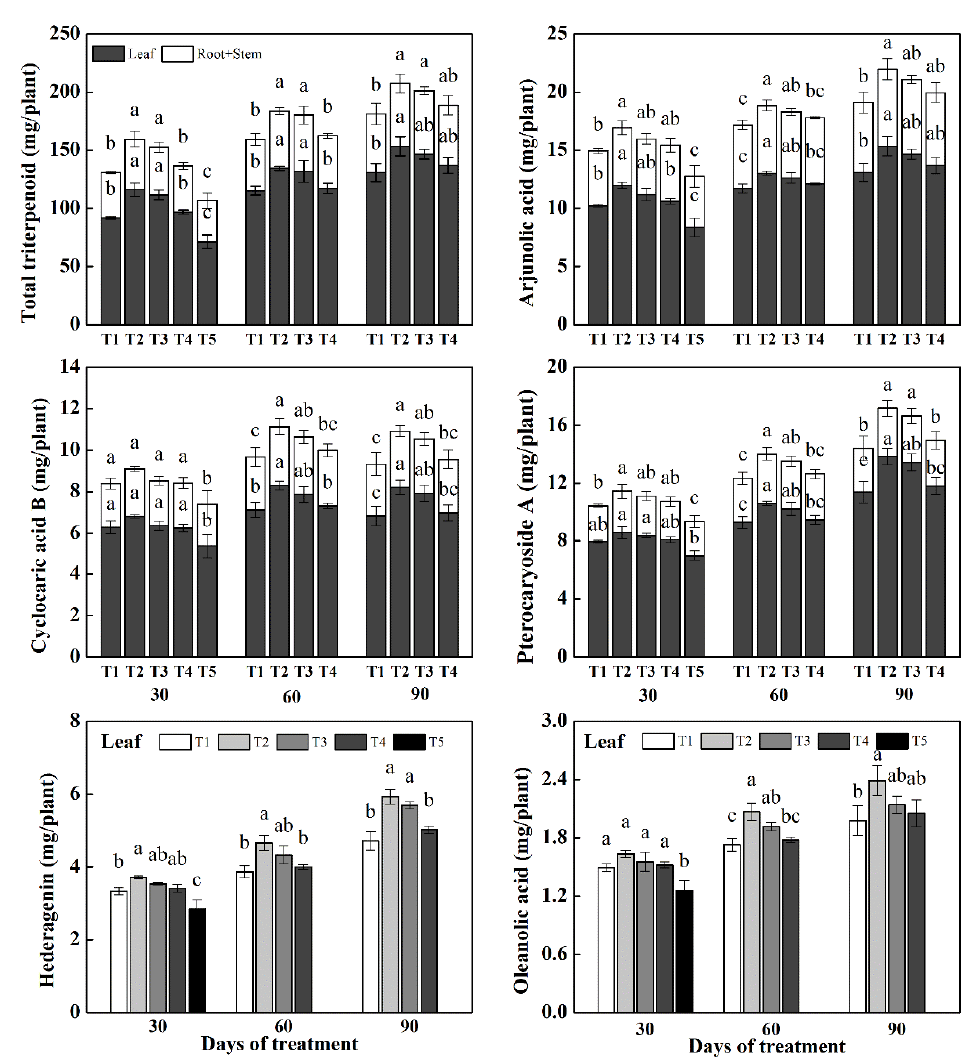
Figure 5. Effects of NO 3− /NH 4+− ratio on the accumulations of total triterpenoid and five individual triterpenoids in leaves and whole plants of C. paliurus seedlings sampled at 30, 60 and 90 days after the treatments. Different letters indicate significant differences among different NO 3− /NH 4+ ratio treatments for the same category according to Tukey’s test ( p < 0.05). All C. paliurus seedlings had died at 52 days after the treatment in T5.